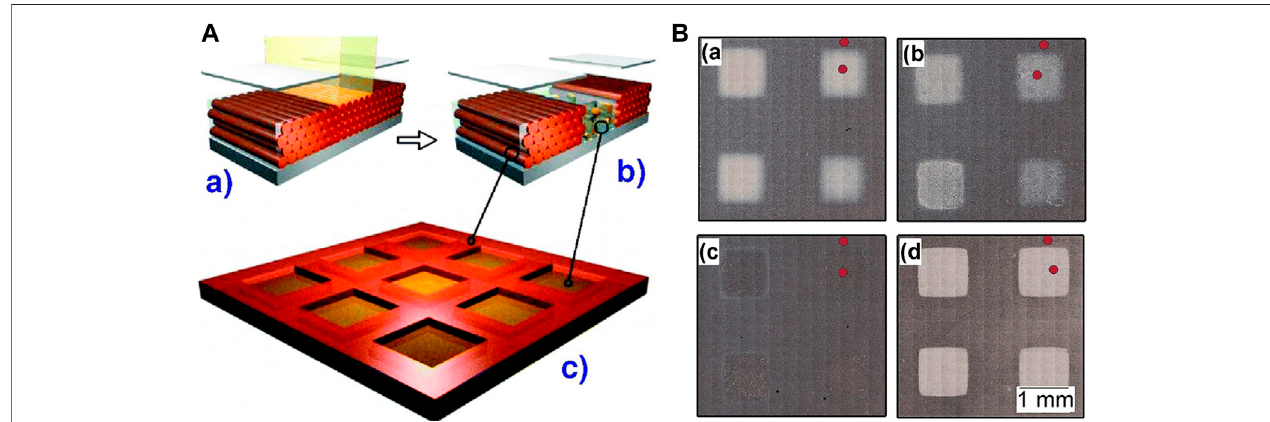
FIGURE1| Ontheleft (A) ,schemeofthepreparationofmesoporousandmesostructuredpatternsinsilica fi lms. (a) themesostructured fi lmsareirradiatedwithUV light through a mask. (b) The area irradiated loses the order and becomes mesoporous. (c) Mesotrusctured and mesoporous areas are generated. Reprinted with permissionfromInnocenzietal.(2008).Copyright © 2008AmericanChemicalSociety.Ontheright (B) ,opticalimagesofmesostructuredmesoporous fi lmspreparedby masked deep-UV exposure (a) . The fi lms were developed 10, 85 and 3,600 s in NaOH solution (b and c , d) . The red dots mark the spots at which the fi lms were characterized by FTIR spectroscopy and image ellipsometry. Reprinted with permission from Dattelbaum et al. (2003). Copyright © 2003 American Chemical